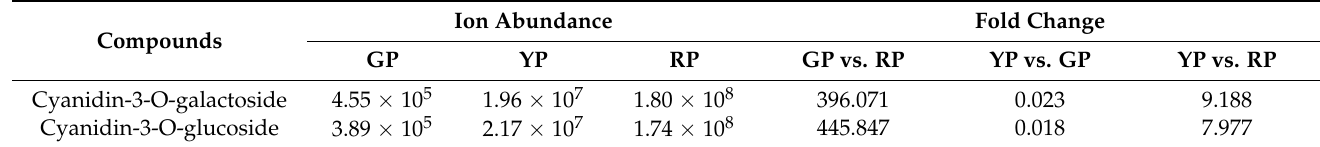
Table 1. Differential accumulation of anthocyanins in the pericarp of the three variations.